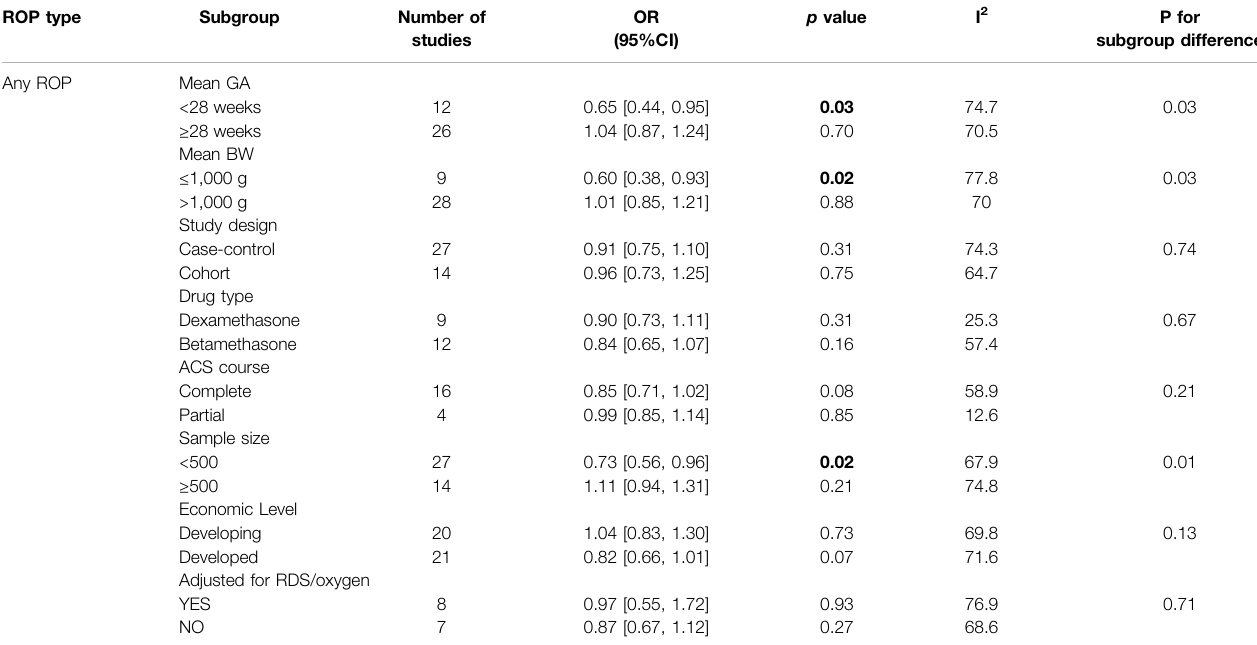
TABLE 1 | Subgroup analysis of any stage ROP risk in the ACS-exposed group. ROP type